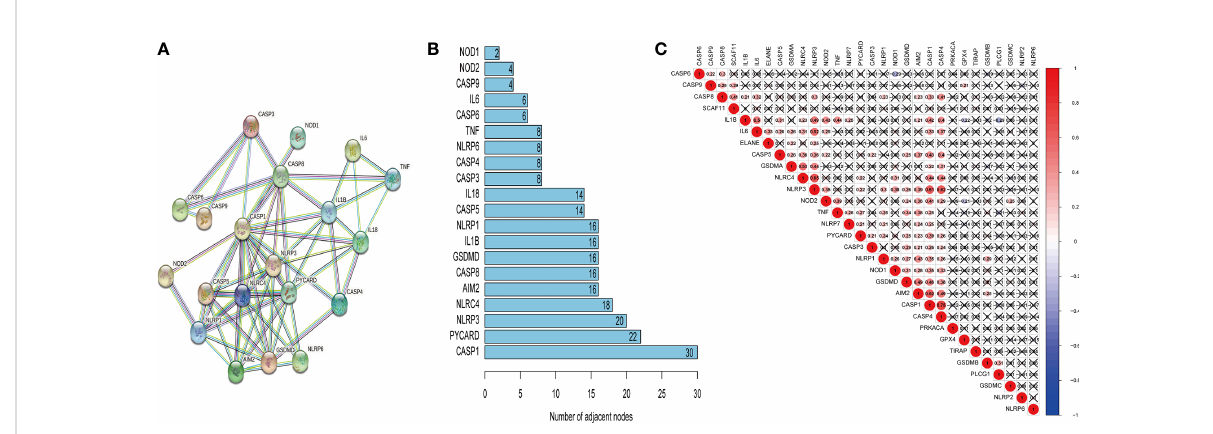
FIGURE 2 The correlation of pyroptosis-related genes. The PPI network of pyroptosis-related genes (A) , number of interaction nodes among pyroptosis- related genes (B) , and Pearson correlation analysis of pyroptosis-related genes (C) . Red indicates positive correlations, and blue indicates negative correlations. The darker the color, the stronger the correlation. X indicates p >